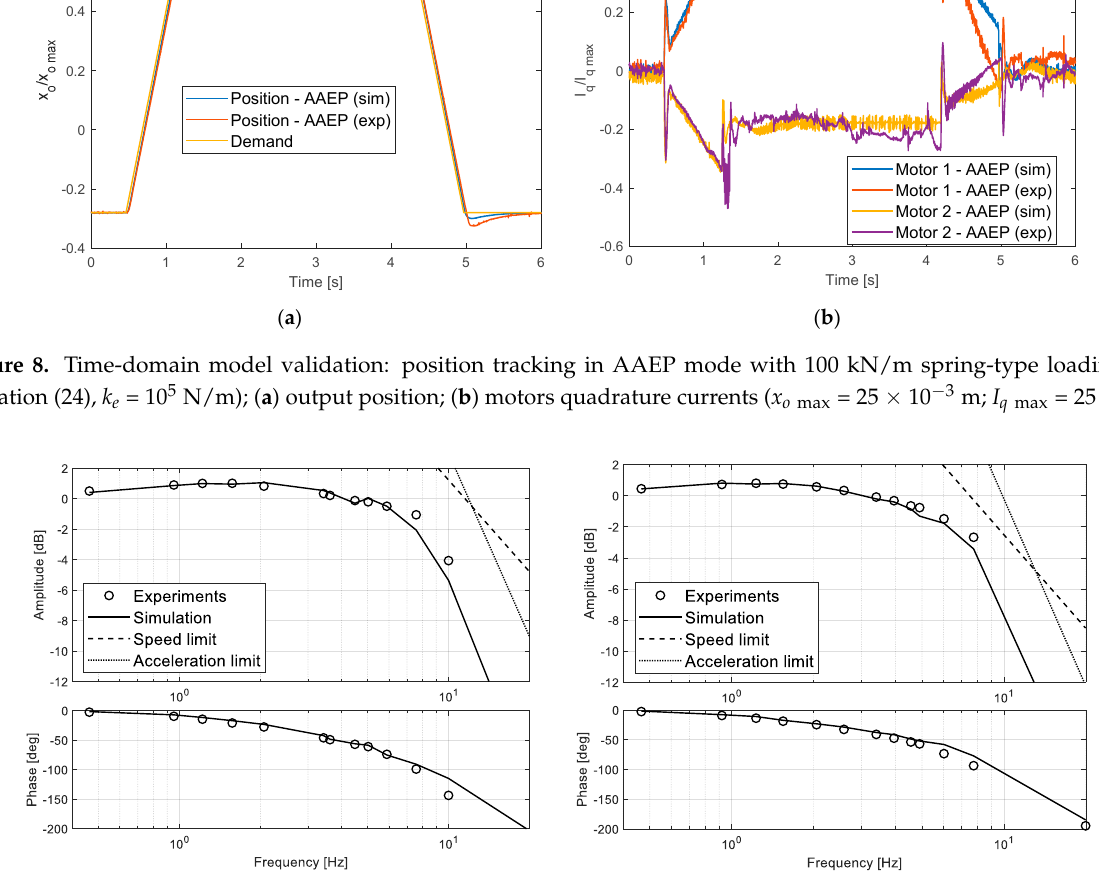
Figure 9. Frequency-domain model validation: position tracking at 1% maximum demand amplitude (0.5 mm), with 2 kN compressive load; ( a ) ASB mode; ( b ) SBA mode.